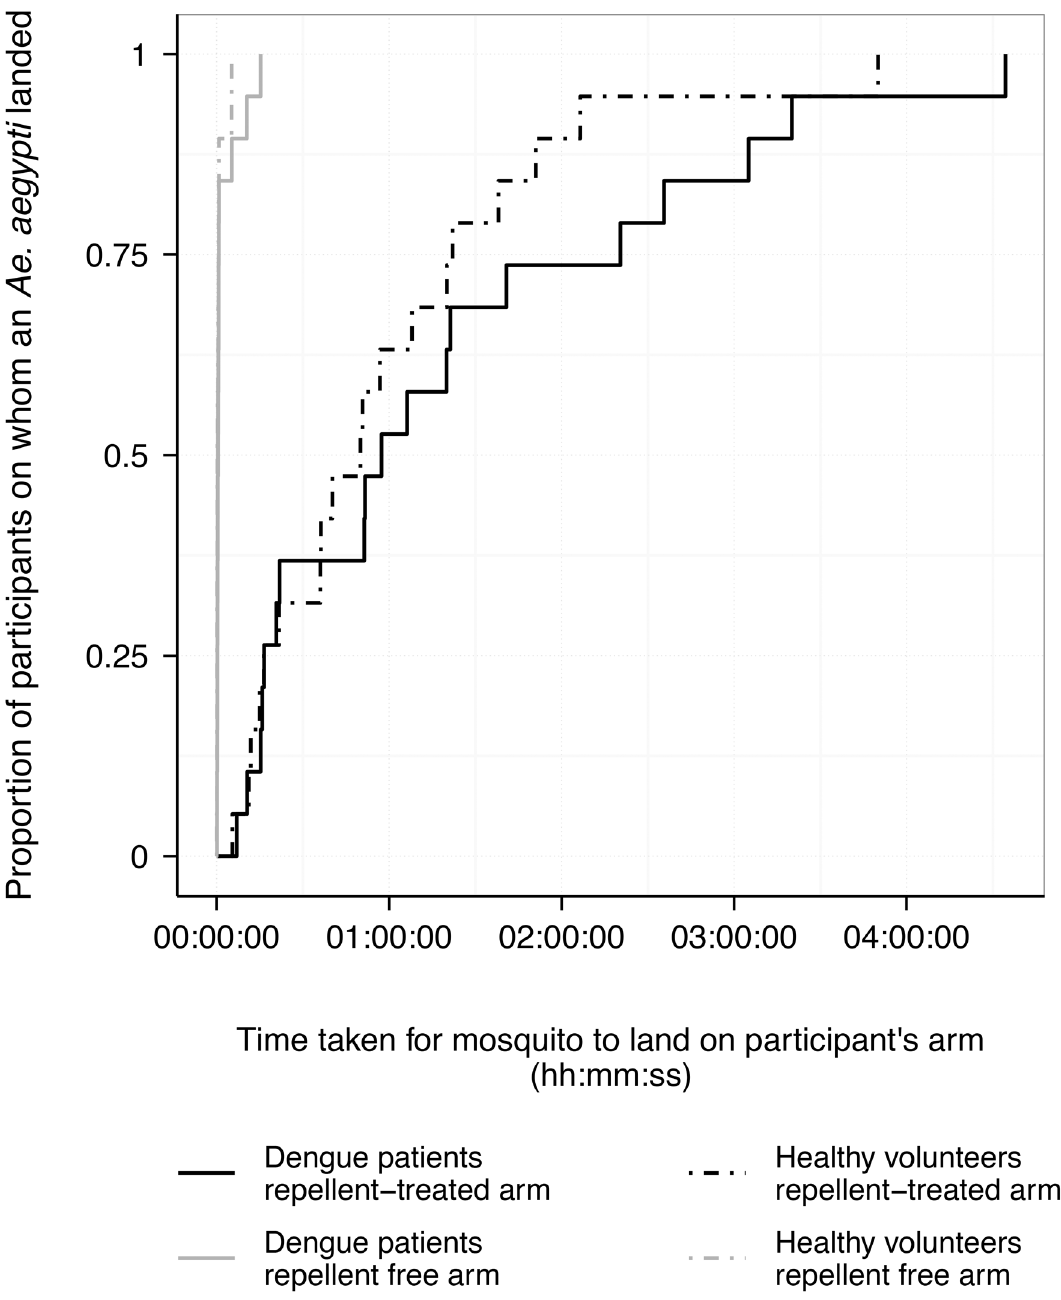
Fig 5. Kaplan-Meier curves showing the time-to-landing for mosquitoes on participants ’ skin. Curves estimate the elapsed time to Aedes aegypti mosquito landing on both repellent-free and repellent-treated arms of febrile dengue patients versus non-febrile healthy controls. No statistical differences were observed between estimates for participant groups for either treatment group (repellent-treated or repellent-free arms).